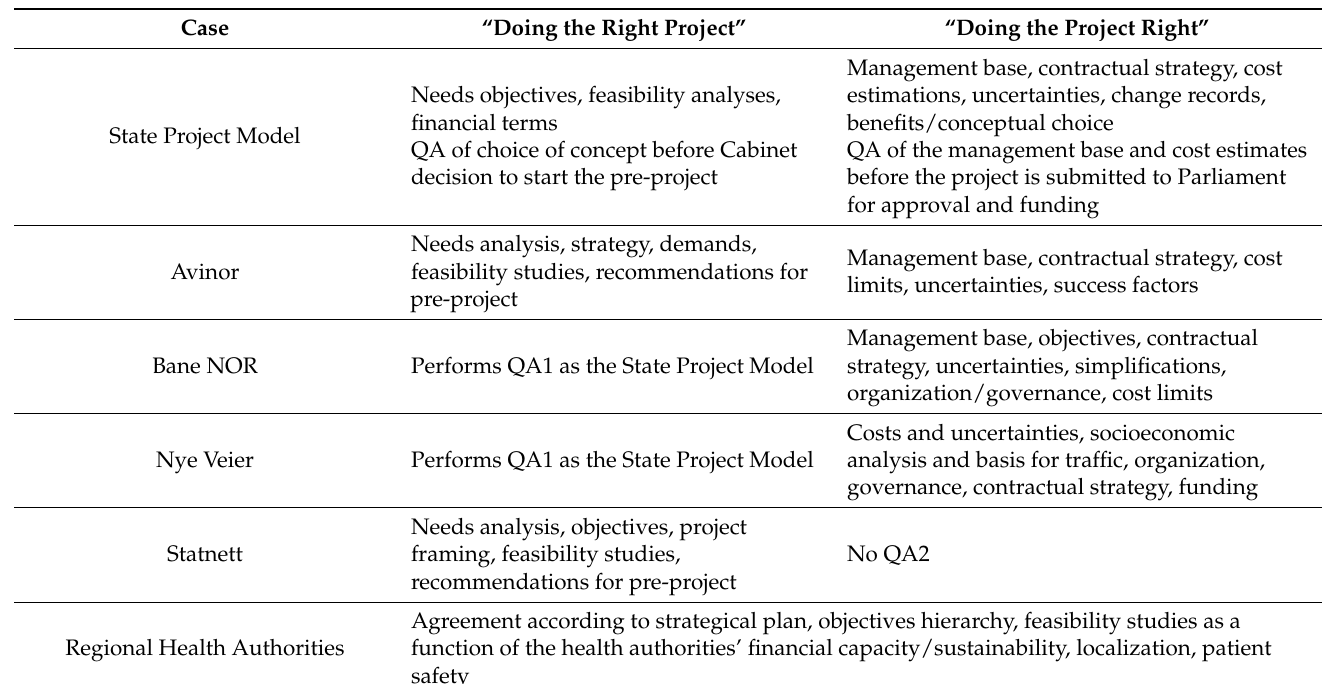
Table 4. Different arrangements’ topics subject to